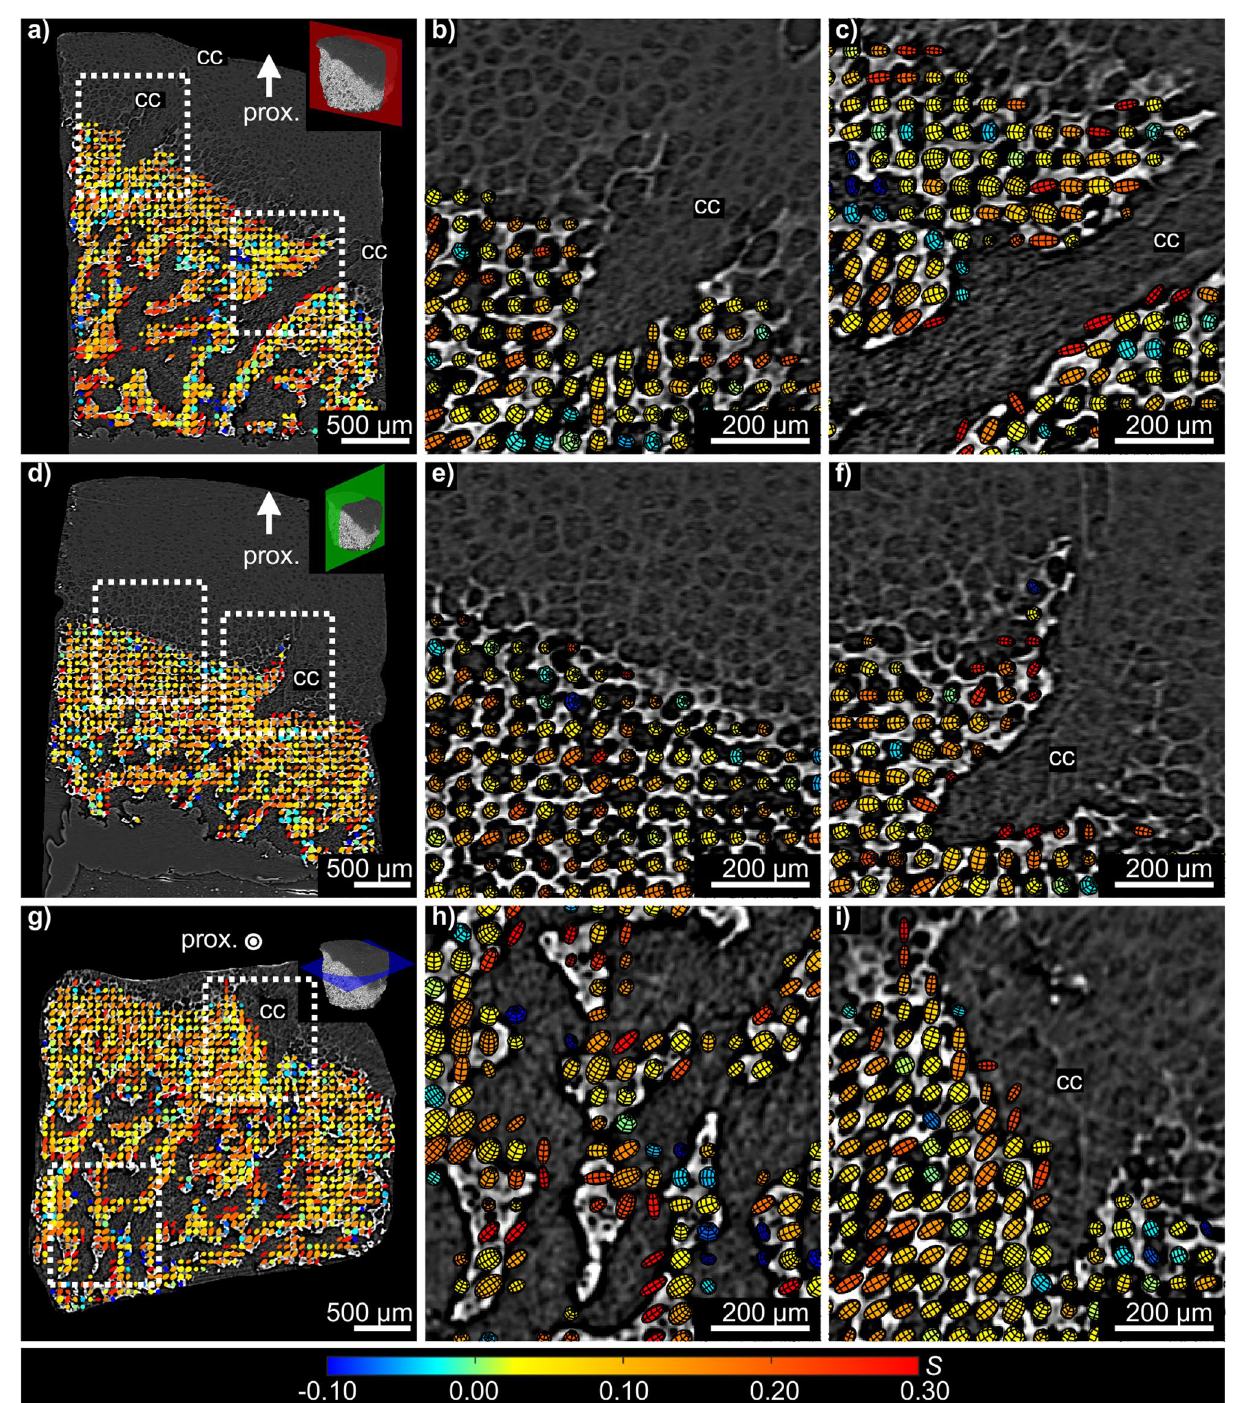
Figure 3. Registered cross-sections from XRDTT and PPC-CT. Variations in the preferred crystallite orientation of HA are shown for three orthogonal and intersecting cut planes in (a,d,g) . The coloured ellipsoids give the preferred orientation direction of the HA crystallites c -axis based on directional HA002 scattering. The ellipsoid volumes are scaled with the intensity, while the elongated shape and colour both indicate the Hermans’ parameter S . Prox. proximal, cc cartilage